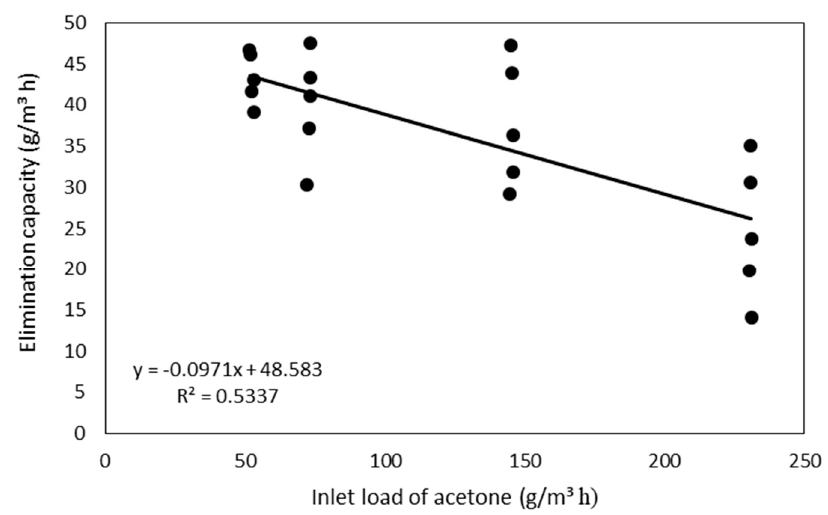
Figure 5. Influence of inlet acetone loading on the elimination capacity of the trickling filter.